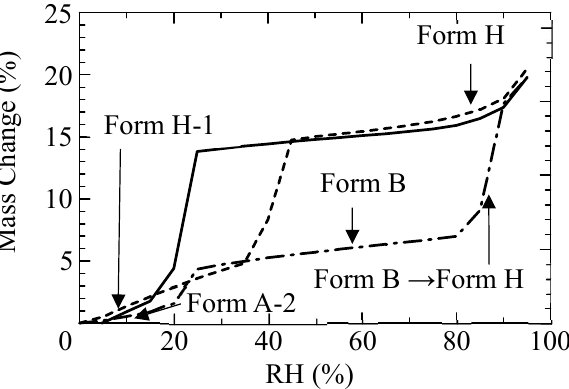
Figure 15. Water absorption of Form A-2 along the dashed-dotted curve. Form A-2 finally changed to Form H via Form B at 25 °C.